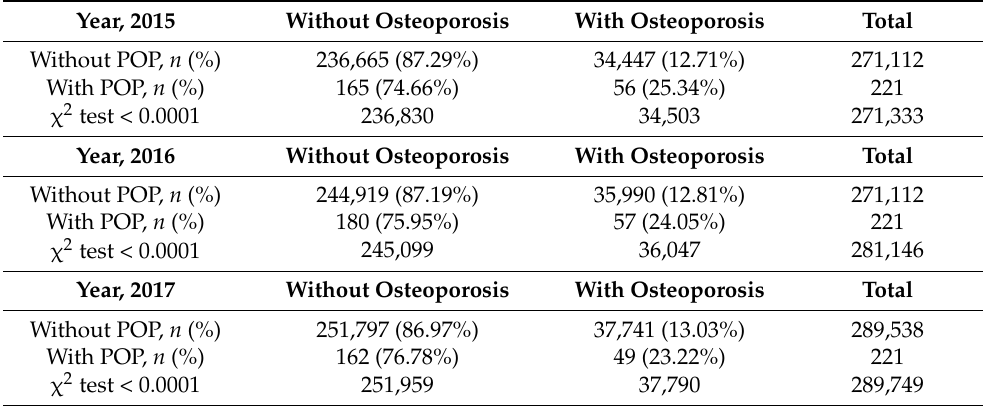
Figure 2. Prevalence of pelvic organ prolapse (POP) among women with osteoporosis, aged over 50 years ( p < 0.0001). Table 3. Pelvic organ prolapse (POP) and osteoporosis prevalence in women aged over 50 years, as defined by the Korean Informative Classification of Diseases.